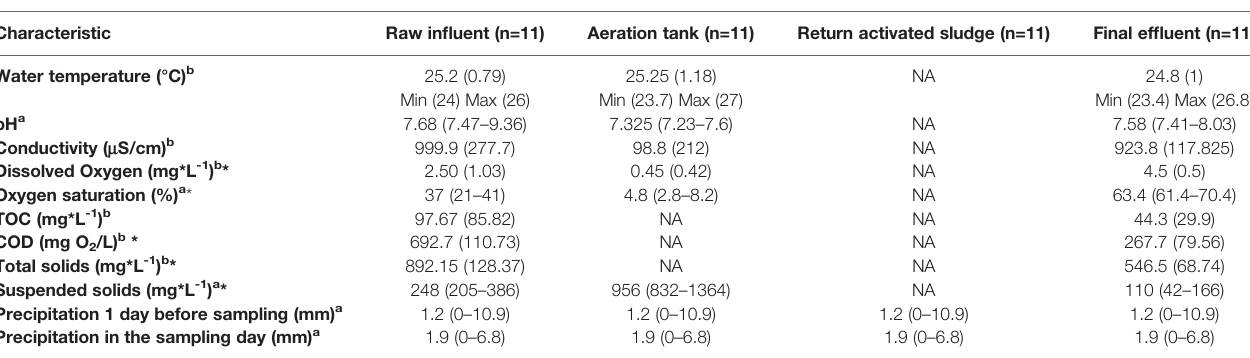
TABLE 1 | Characteristic of wastewater and atmospheric